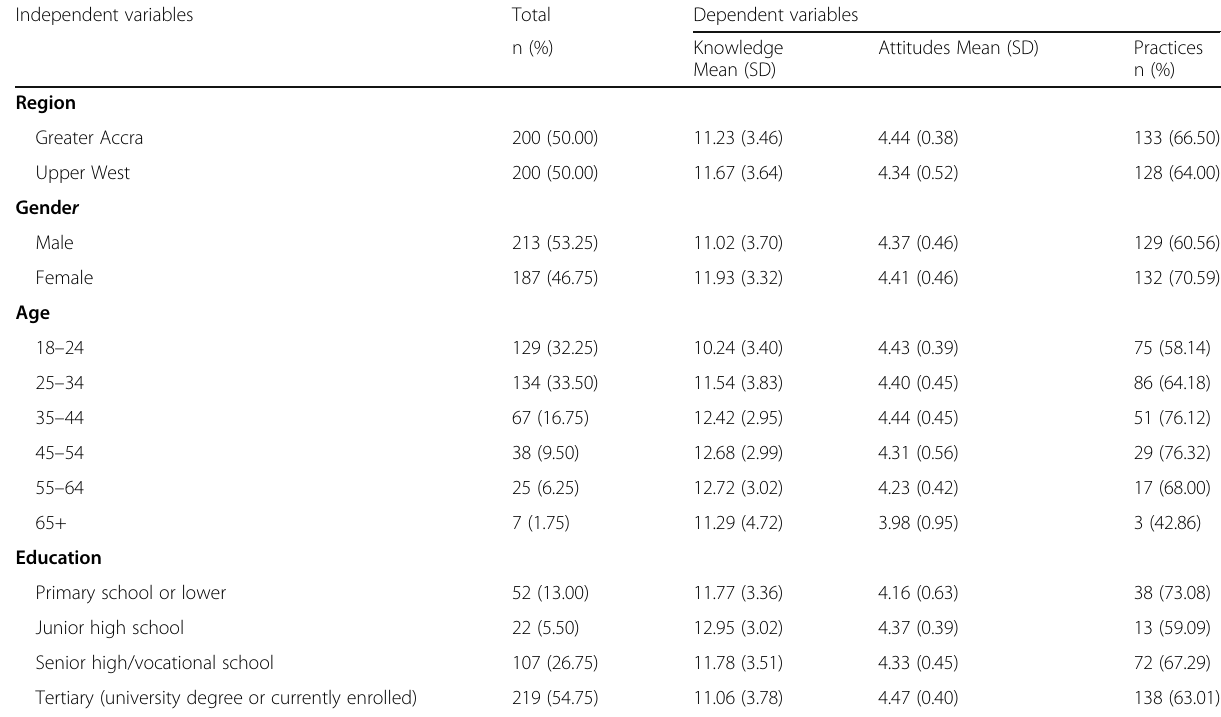
Table 1 Description of the sample ( n = 400) Independent variables